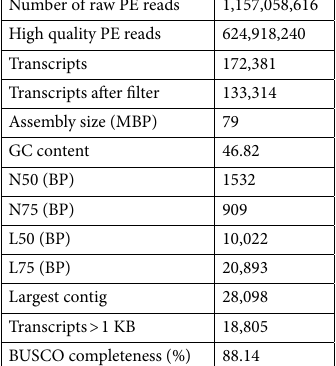
Table 1. Summary of the transcriptome assembly and quality assessment of B.